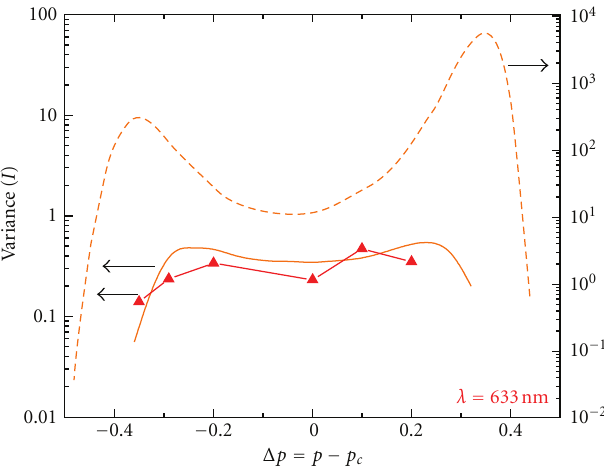
Figure 2: Near-field intensity variance var( I ) as a function of silver concentration Δ p = p − p c , obtained experimentally (solid line with triangles) and numerically with (dotted line) and without (dashed line) spatial averaging [22, Figure 1].